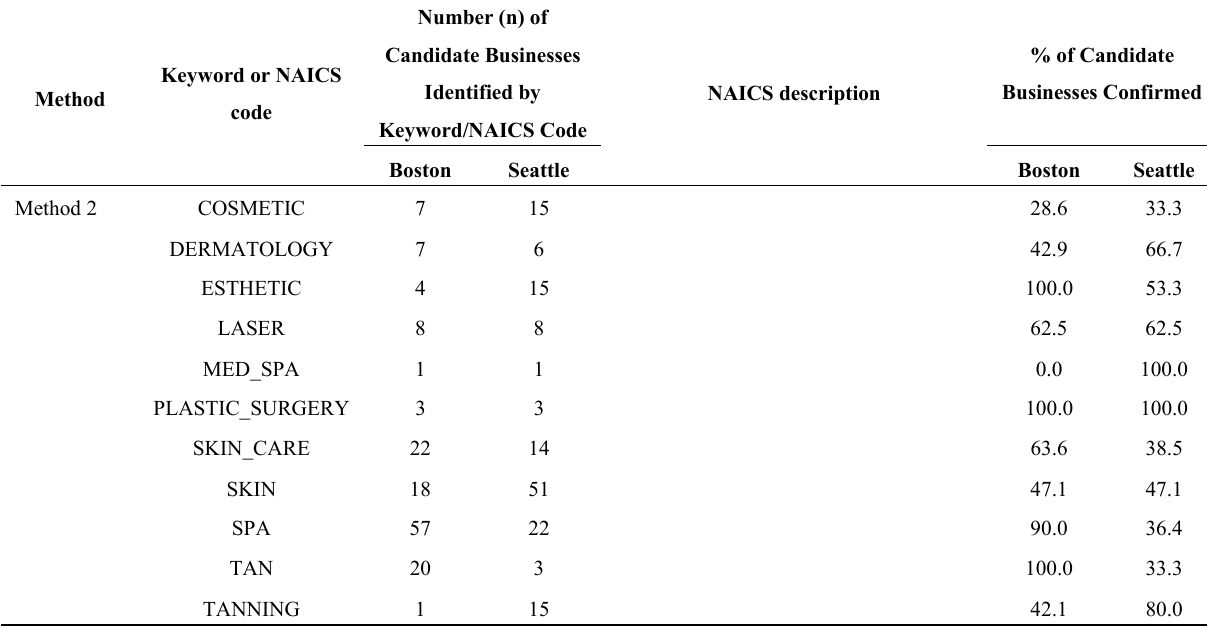
Table 2. Business identification and validation: Percentage of candidate businesses identified by keyword or North American Industrial Classification System (NAICS a ) code that were confirmed as cosmetic-procedure business via confirmation procedures b , by method, in Boston and Seattle,